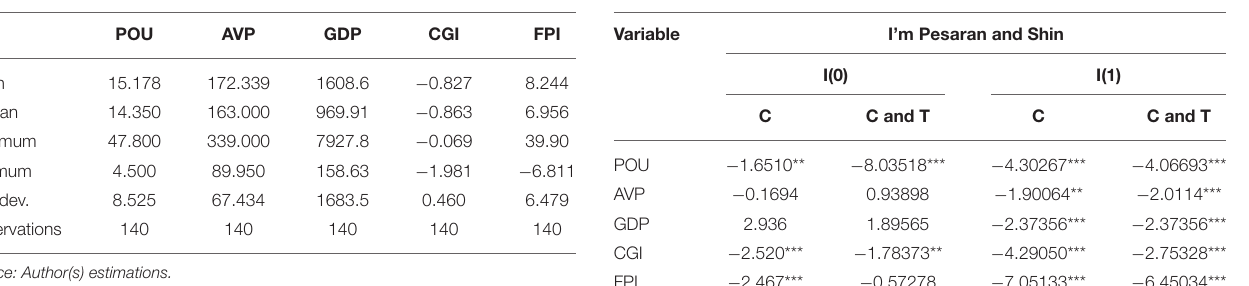
TABLE 3 | Descriptive